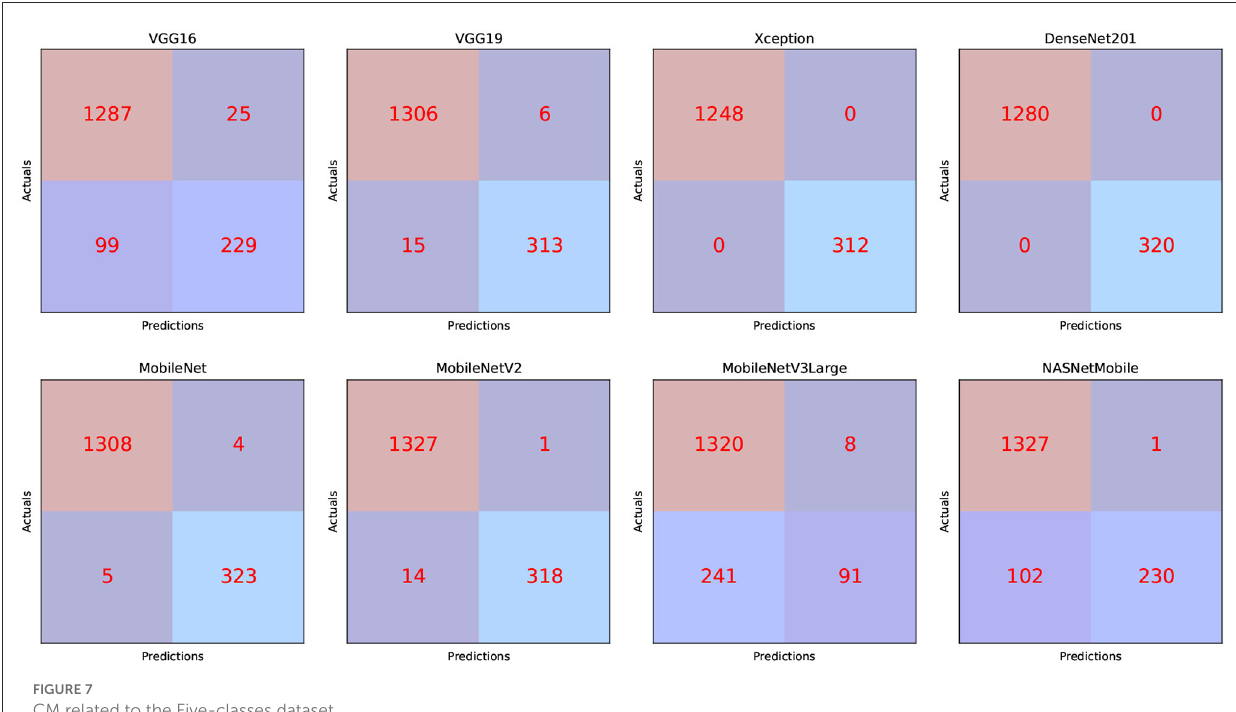
FIGURE7 CM related to the Five-classes dataset.